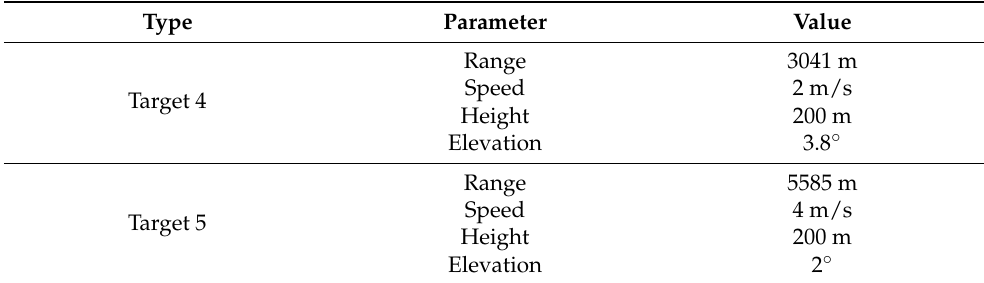
Figure 10. Field experiment scene: ( a ) the satellite image of the radar location and surroundings (courtesy of Google Maps); ( b ) the actual view from the radar. Table 5. Target parameters in field test.